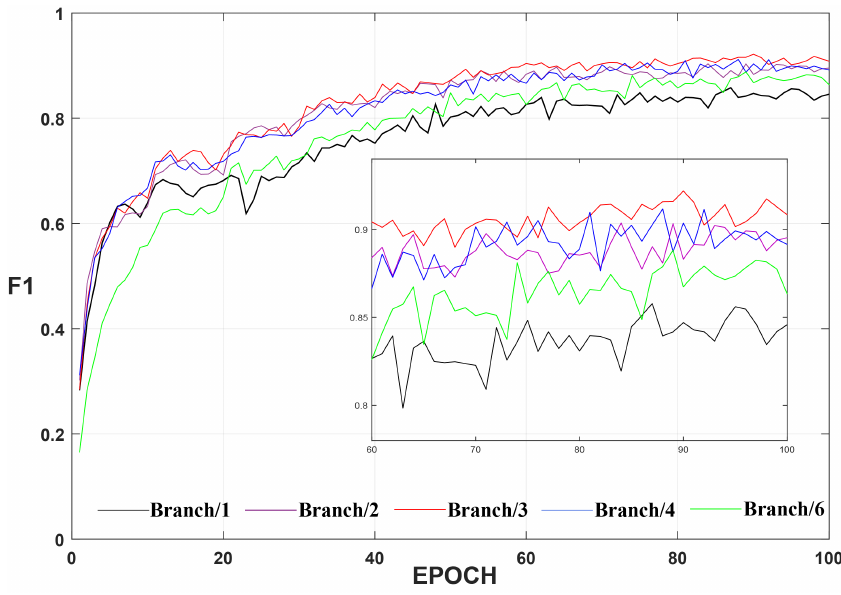
Figure 14. Validation results F1 for different branches of HARM on the BCDD dataset. Smaller rectangular boxes show a clearer result. Table 7. Ablation Experiment of rationality analysis of the hierarchical structure in HARM on the BCDD dataset. The highest score is marked in bold. All scores are expressed as a percentage (%). HARM_